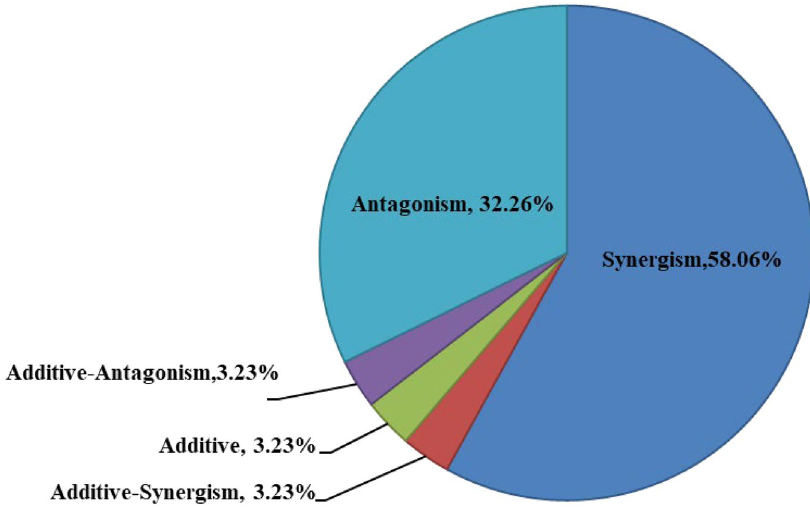
Figure 1. Interaction patterns of cadmium in combination with five pesticides in larval